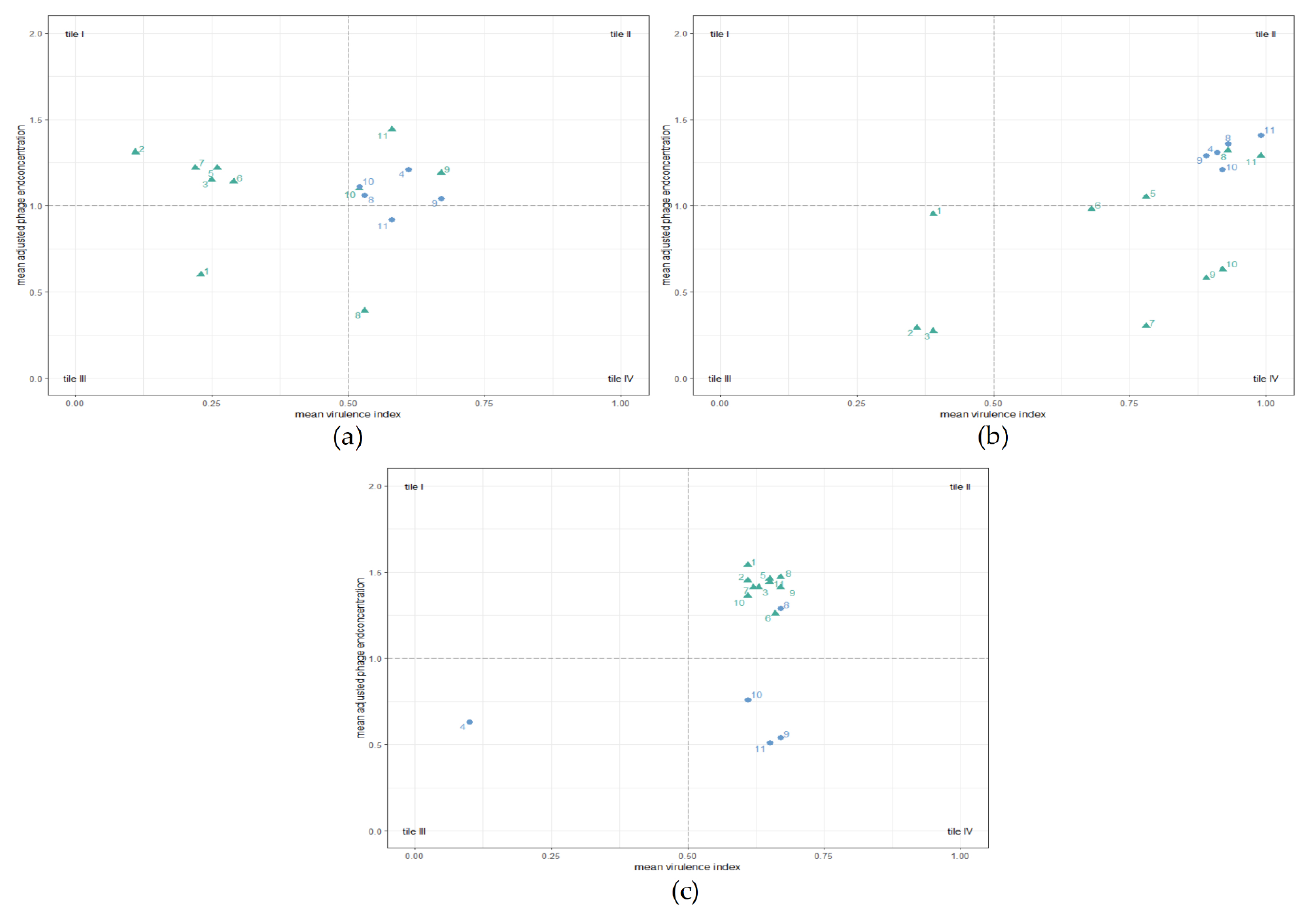
Figure 6. Planktonic Killing Assays (PKA): mean virulence index (mean vi ) and mean adjusted phage concentrations after 24 h (mean c24 ). C. jejuni LH83 ( a ), Cj18 ( b ), and C. coli Cc4 ( c ) were exposed to three group II phages (CPL1/2, CP218-2c2, and CP288/3) or one group III phage (CP1-1) in one-, two-, or four-phage PKAs at MOI input 10 or MOI input 0.001. Experiments were performed in triplicate or quadruplicate. For all applications, the mean vi and the mean c24 were calculated. Color coding indicates the mean c24 of group II phage(s) ( ▲ ) or group III phage ( ● ). Plots were divided into four tiles. Tiles I and III represent suboptimal, while tiles II and IV represent optimal mean vi values. Tiles III and IV represent suboptimal phage or no phage replication, while tiles I and II represent optimal phage replication. Number codes representing phage applications: 1—CPL1/2; 2—CP218-2c2; 3—